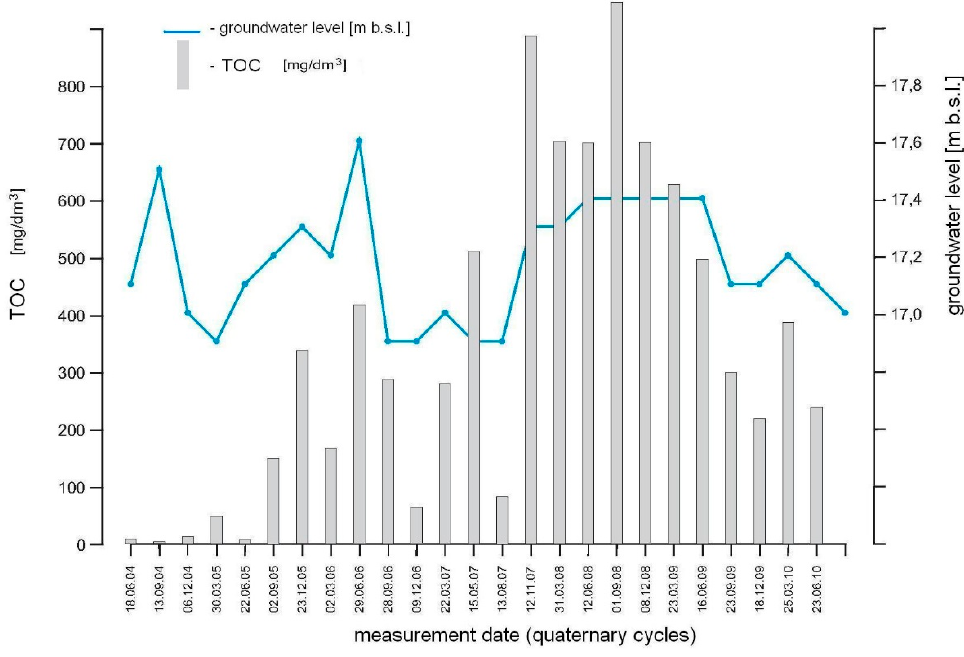
Figure 3. Total organic carbon (TOC) and ground water table changes over time. Table 1. The results of a groundwater quality assessment for a selected piezometer.